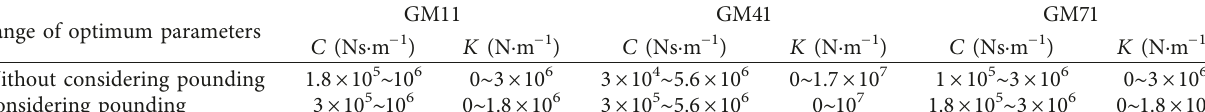
Table 4: Comparison between the structures considering pounding and without considering pounding. Range of optimum parameters Without considering pounding Considering